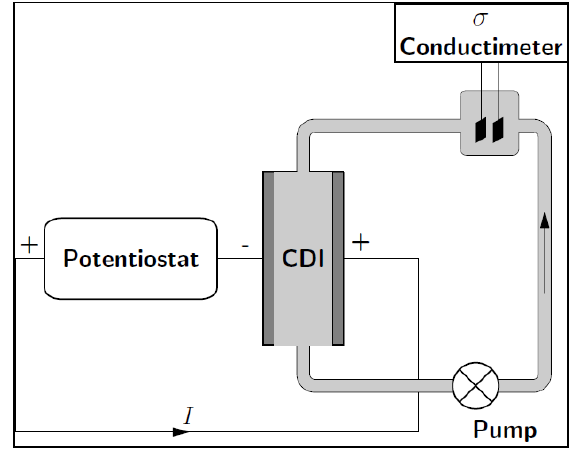
Materials 2020 , 13 , x FOR PEER REVIEW Figure 1. Schematic diagram of a capacitive deionization (CDI) set up. Figure 1. Schematic diagram of a capacitive deionization (CDI) set up.